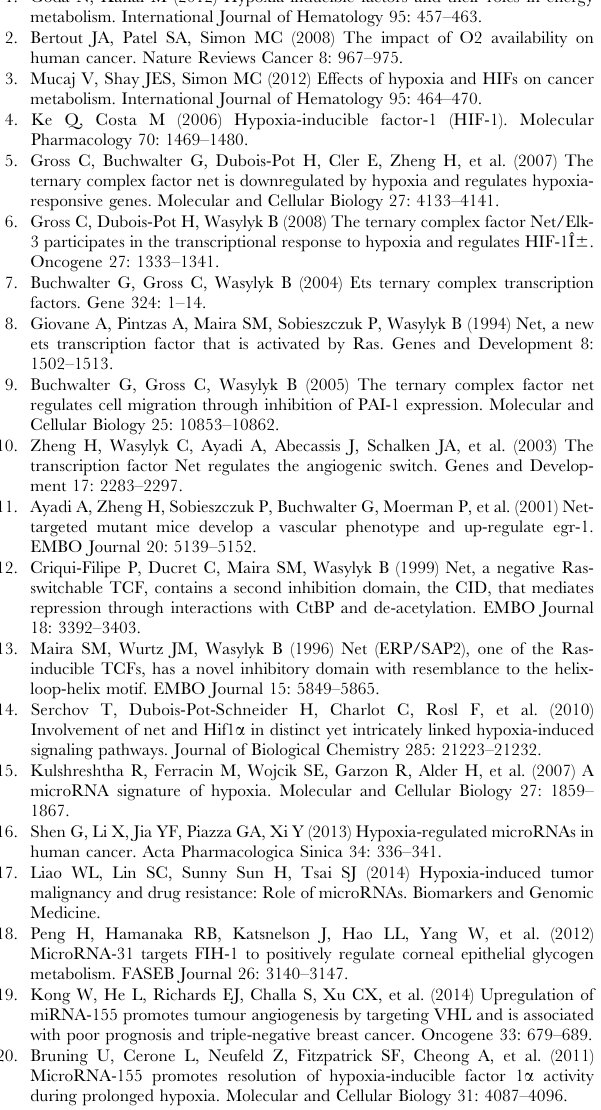
MTT assay in comparison to media without cells. Measurements were taken at the start of the experiment (lane 1) and after 24 and 48 hours of normoxia (lanes 2 and 3, respectively) or hypoxia (lanes 4 and 5, respsctively). A further point was taken after within the